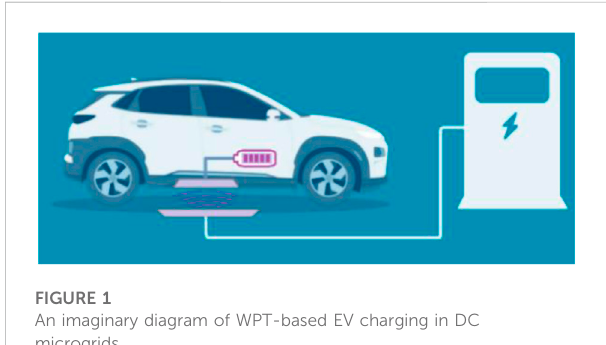
FIGURE 1 An imaginary diagram of WPT-based EV charging in DC microgrids.